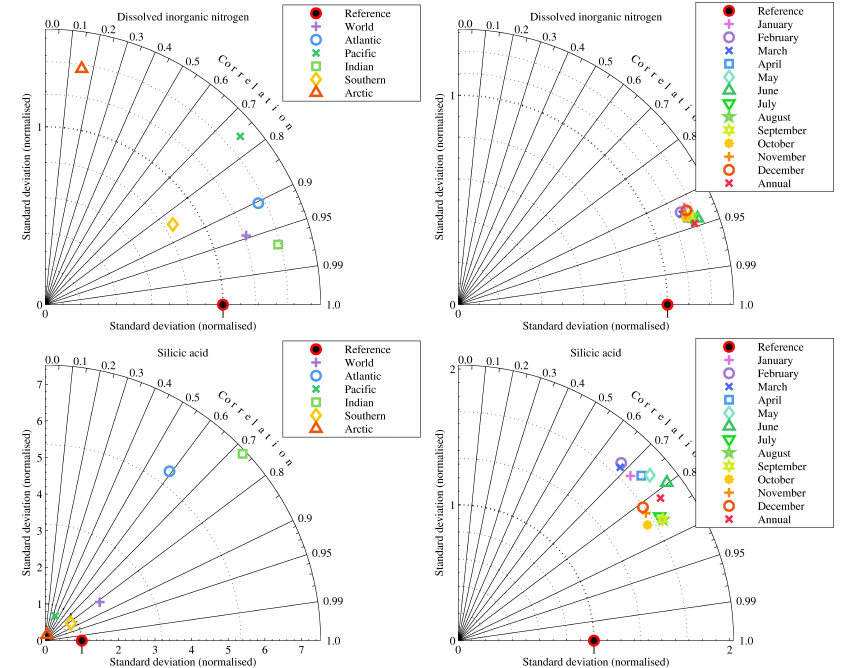
Fig. 14. Taylor diagrams of spatial (left) and temporal (right) model-observation comparisons for surface dissolved inorganic nitrogen (top) and silicic acid (bottom). In the leftmost panels, simulated annual means for different regions are compared to corresponding observational fields. In the rightmost panels, simulated global average means for different months are compared to corresponding observational fields.